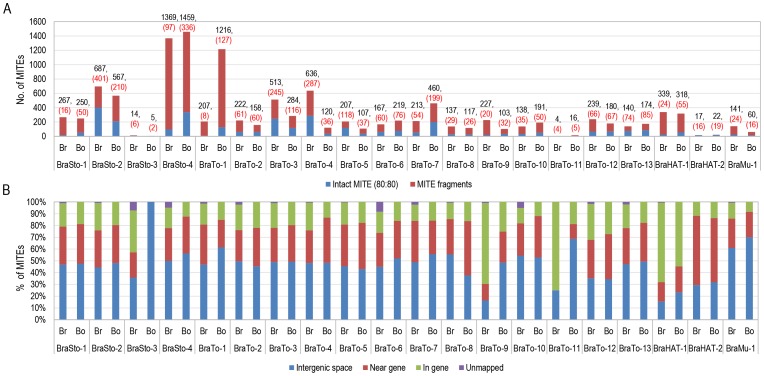
Distribution of 20 MITE families in the B. rapa and B. oleracea genomes.(A) Total number of members of each of the 20 MITE families in the B. rapa and B. oleracea genomes. The total numbers of members and intact members (in parentheses) of the corresponding MITE family are given above each bar. (B) Distribution of total MITE family members in various types of genomic sequence in the B. rapa and B. oleracea genomes (relative percentage). Br and Bo indicate analysis in the B. rapa and B. oleracea genome, respectively.